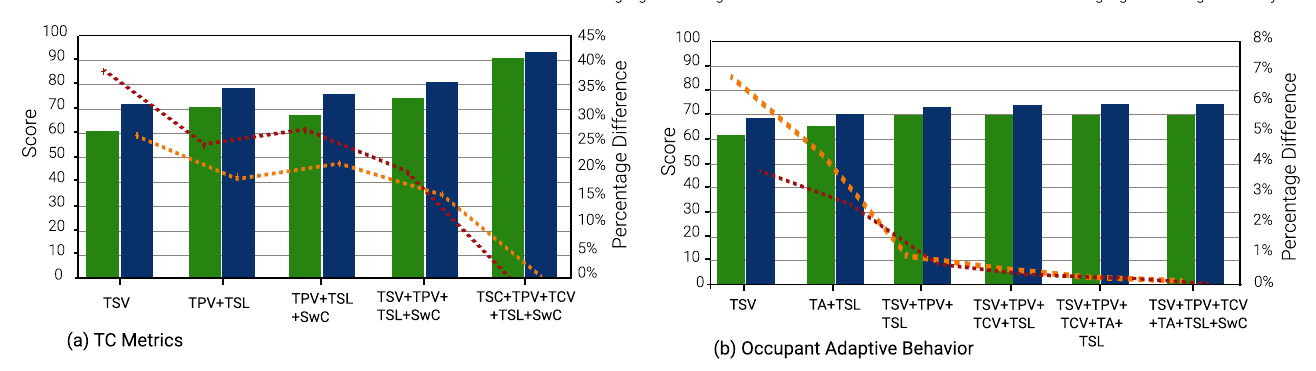
Figure 13. Gradient Boost Algorithm for Summer Survey.